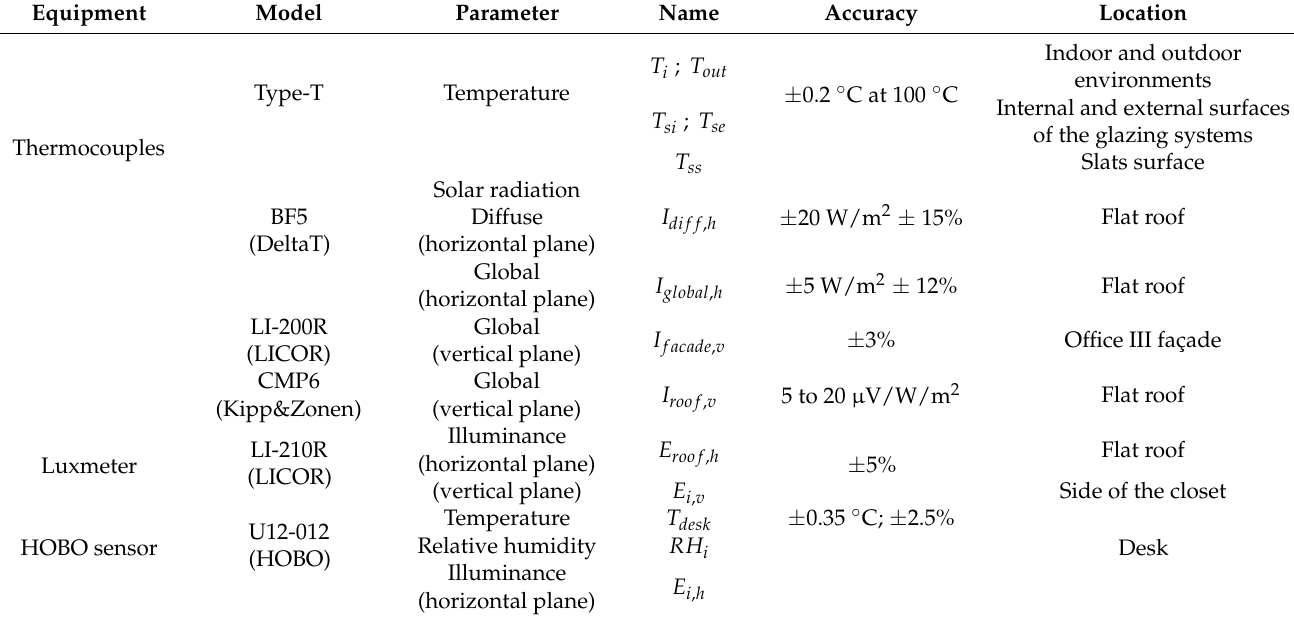
Table 2. Experimental equipment used during the extended field experimental campaign and field measured parameters.